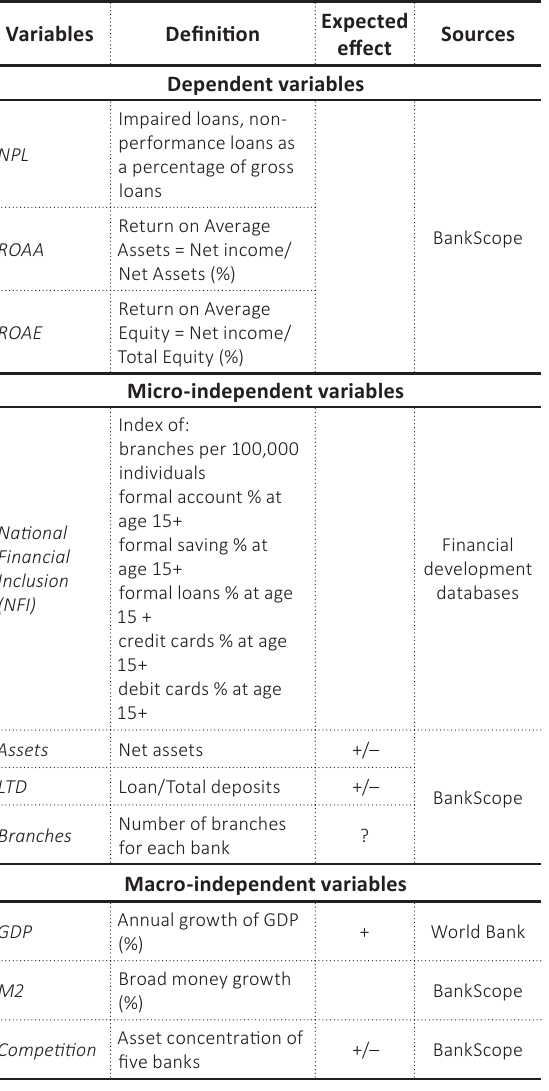
Table 1. Definition of